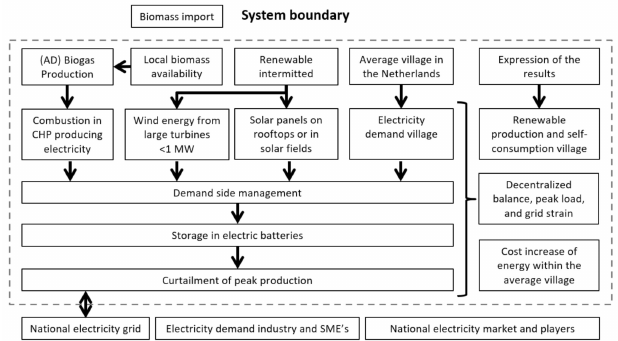
Figure 1. System boundaries of local energy